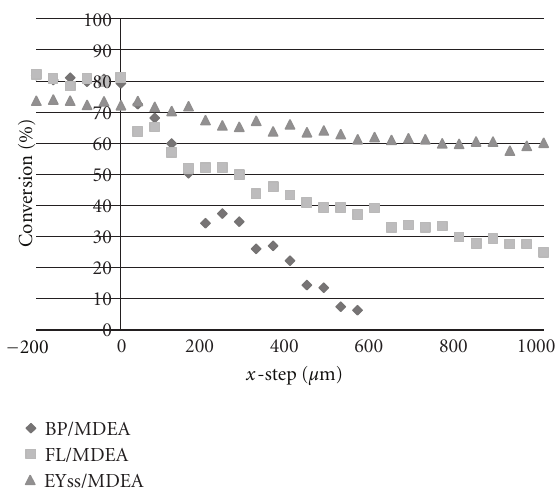
Figure 4: Shadow cure conversion profiles ( x -direction) resulting from three di ff erent dye/amine photoinitiator systems. Negative values of x correspond to the illuminated region, while positive values of x correspond to the masked region. Light source: a 150W xenon lamp, light intensity: 89mW/cm 2 , irradiation time: 15 minutes.